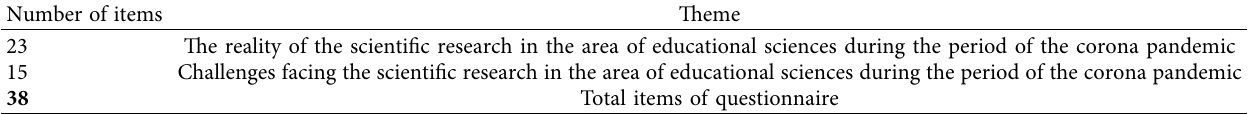
Table 1: Themes and items of the questionnaire.